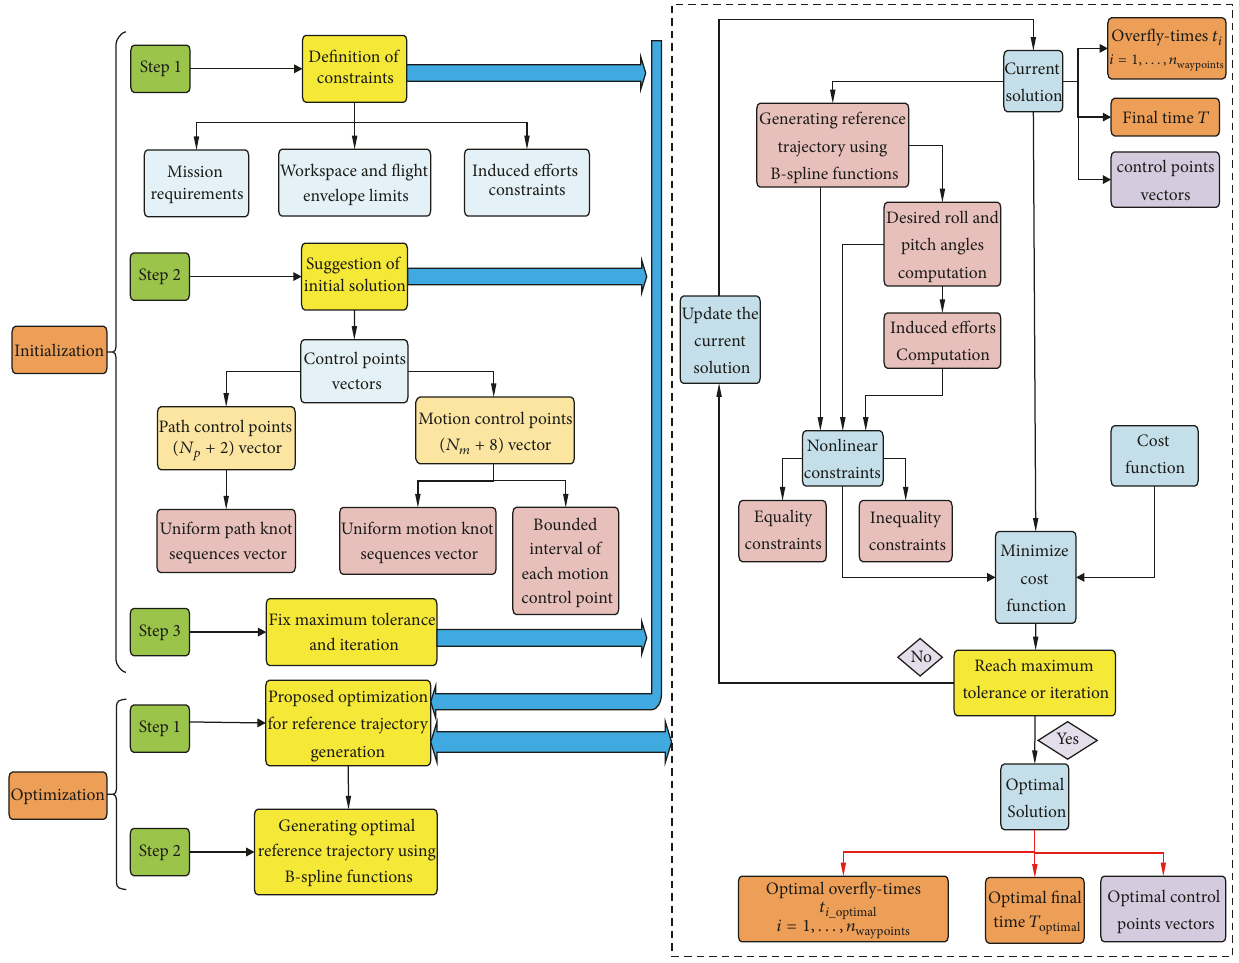
Figure 2: Proposed optimization method